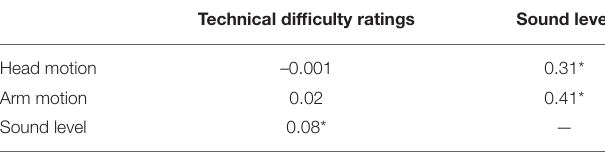
TABLE 3 | Correlations between measures relating to bodily